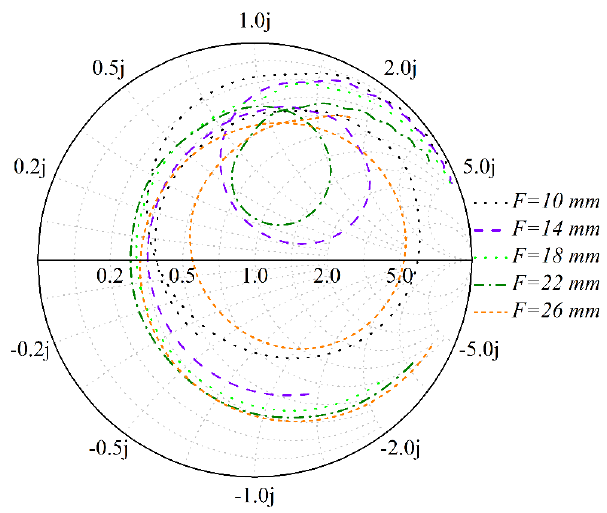
Figure 4. Smith chart showing different values of F : 10 mm, 14 mm, 18 mm, 22 mm, and 26 mm.